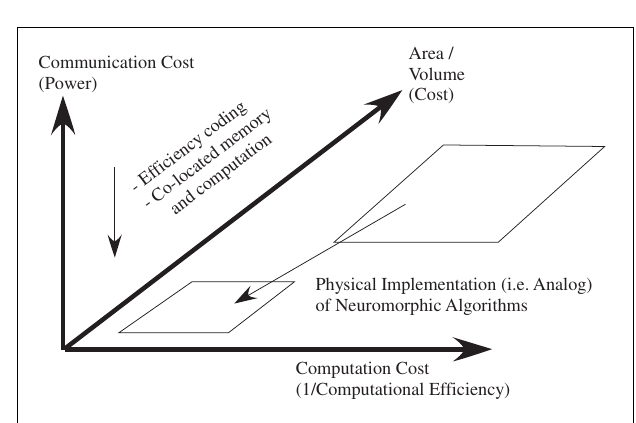
FIGURE 27 | Overview figure illustrating the three dimensions (computational efficiency, communication power, and system area) to optimize to reach large-scale neuromorphic systems. Using physical based (i.e., analog) approaches help to decrease computational efficiency and system area, and heavy use of local communication, integration of memory and computation, as well as low-event architecture reduces the communication power